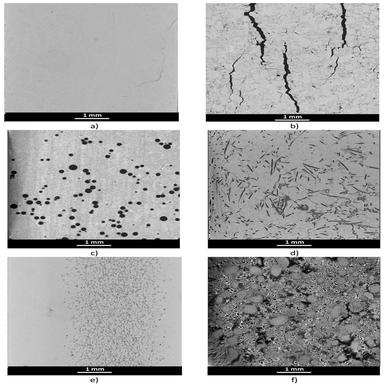
Cross-section images reconstructed from computed X-ray tomography of some of the samples tested in this study: a) reference SiC; b) cracked SiC; c) SiC+10 %vol. balls; d) SiC+7.5 %vol. fibers; e) SiC Galtenco; f) SiC foam.